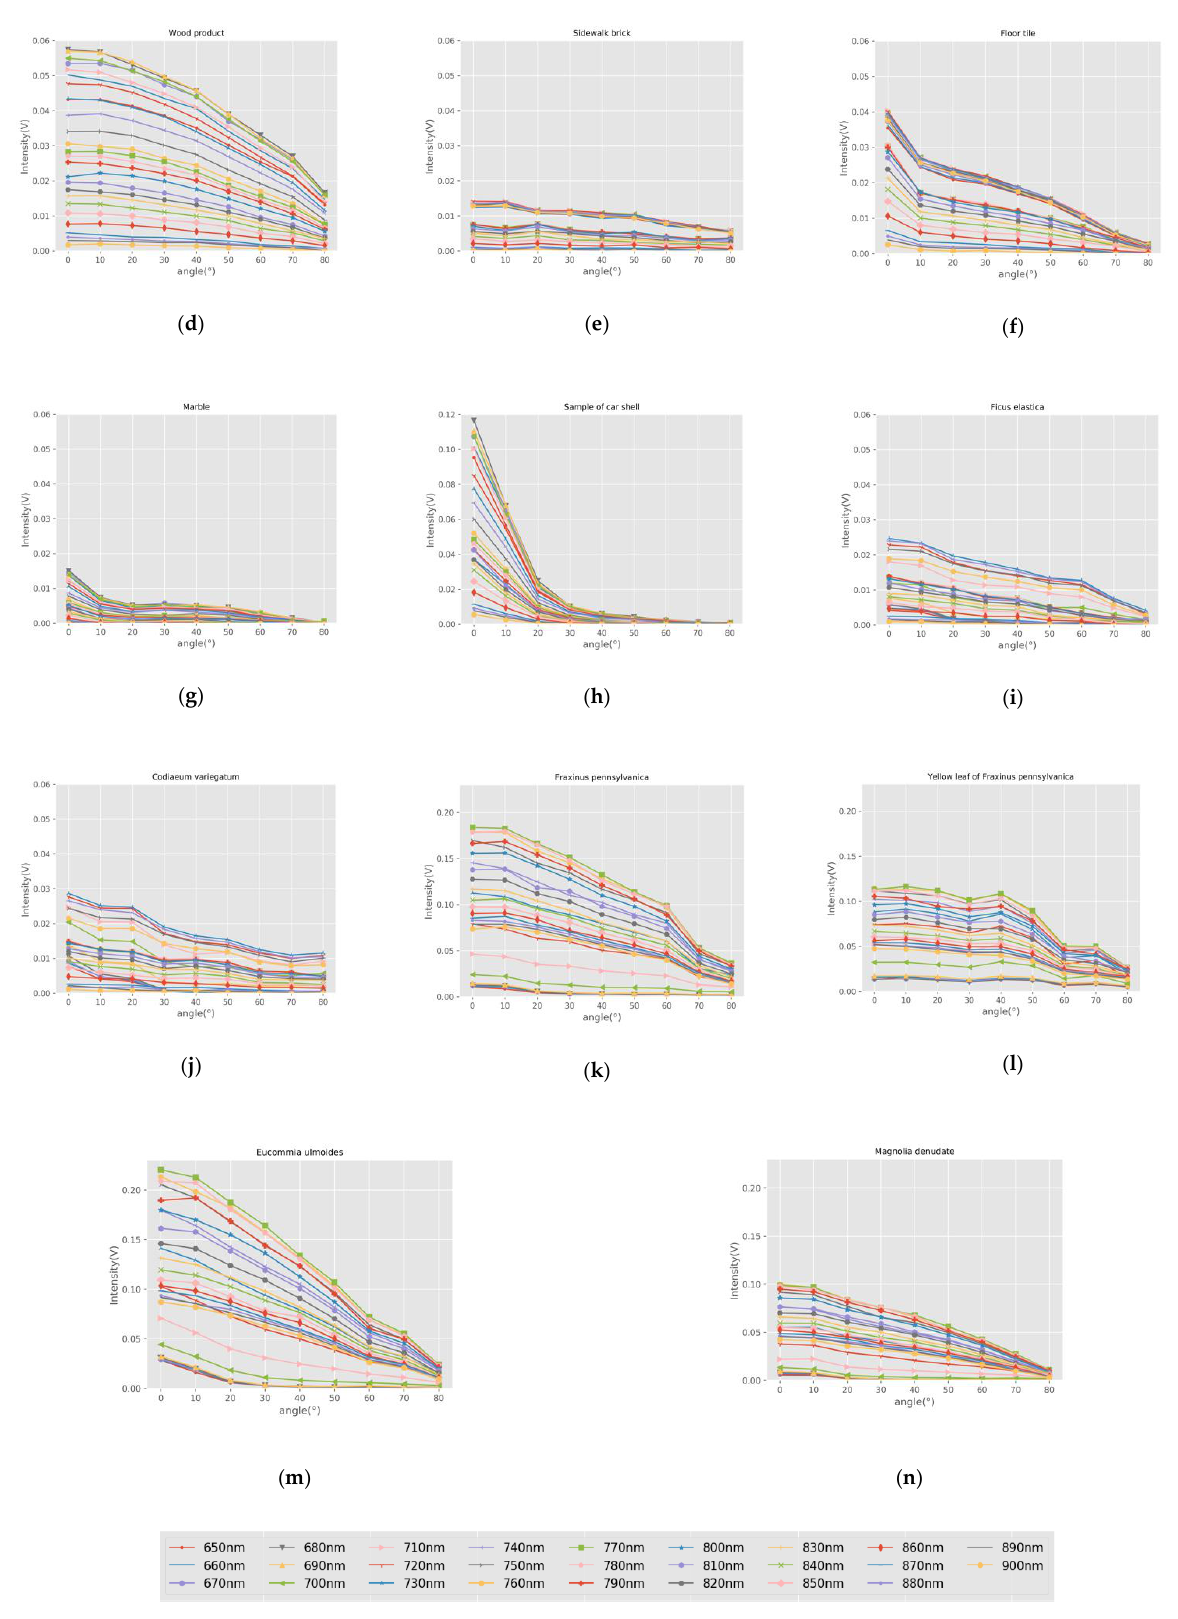
Figure 6. Incidence angle effect at different wavelengths measured with the HSL. ( a ) 100% standard reference board; ( b ) 70% standard reference board; ( c ) 40% standard reference board; ( d ) Wood product; ( e ) Sidewalk brick; ( f ) Floor tile; ( g ) Marble tile; ( h ) Car shell sample; ( i ) Ficus elastic; ( j ) Codiaeum variegatum; ( k ) Fraxinus pennsylvanica; ( l ) Yellow leaf of Fraxinus pennsylvanica; ( m ) Eucommia ulmoides; ( n ) Magnolia